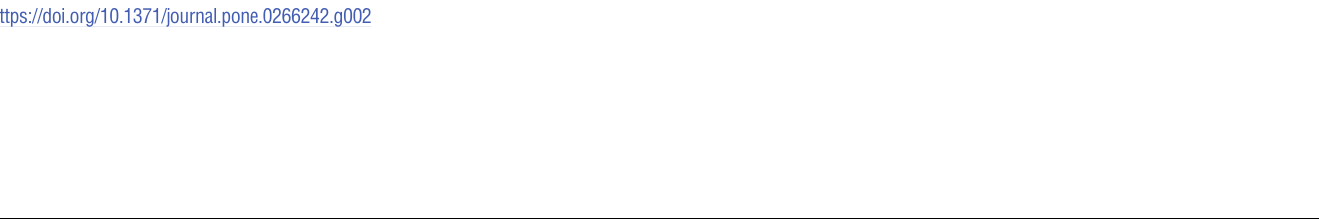
PLOS ONE | https://doi.org/10.1371/journal.pone.0266242 April 5,